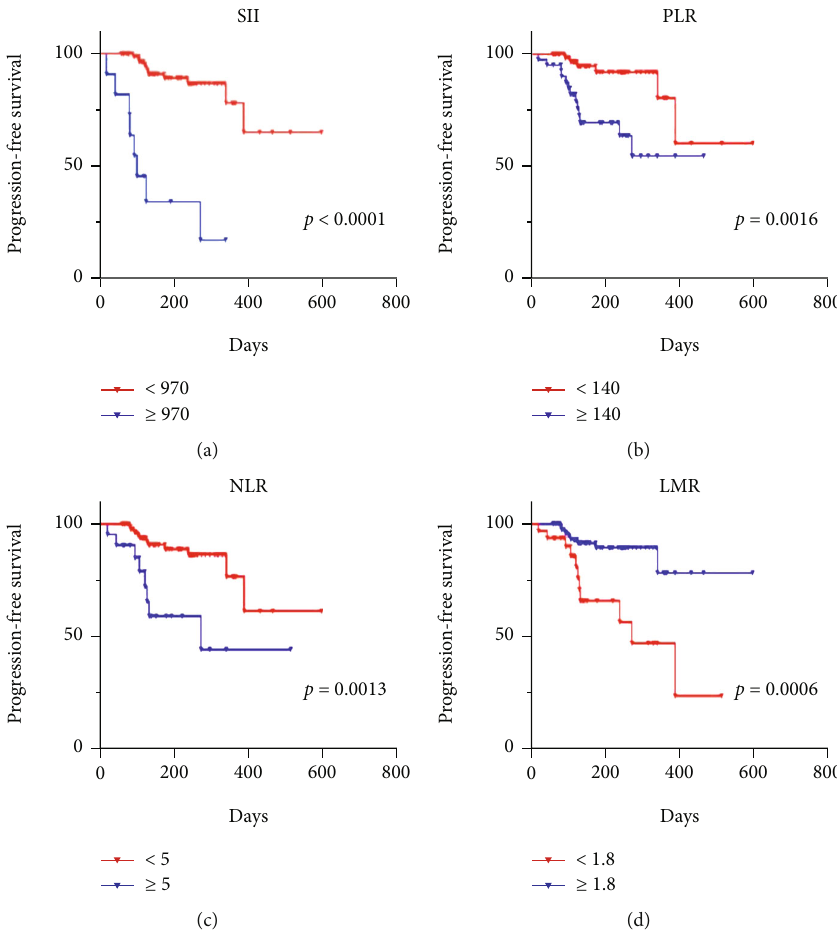
Figure 2: The Kaplan – Meier survival curves indicated that elevated SII, PLR, and NLR were associated with decreased PFS (a – c). Conversely, decreased LMR was associated with decreased PFS